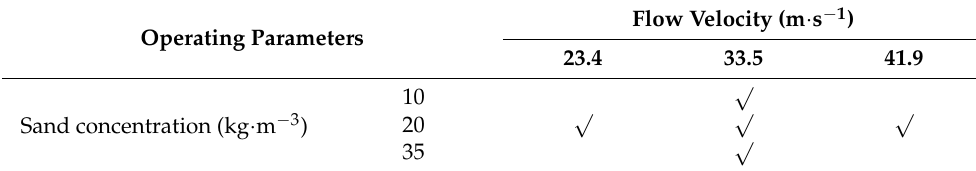
Figure 2. Schematic diagram of the test apparatus ( a ), the rotating disk compartment for the CSE test ( b ), and the corresponding specimen size ( c ). Table 1. Operating parameters of the CSE tests in 3.5 wt.%